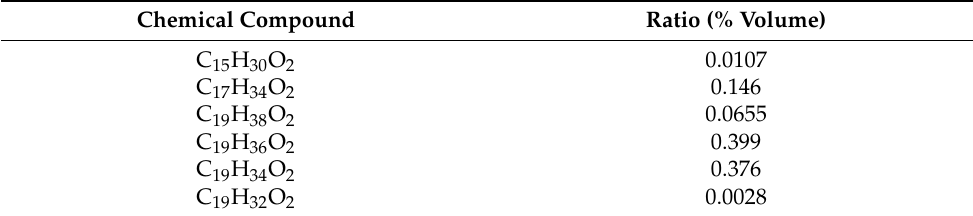
Table 4. Chemical composition of fuel B100.